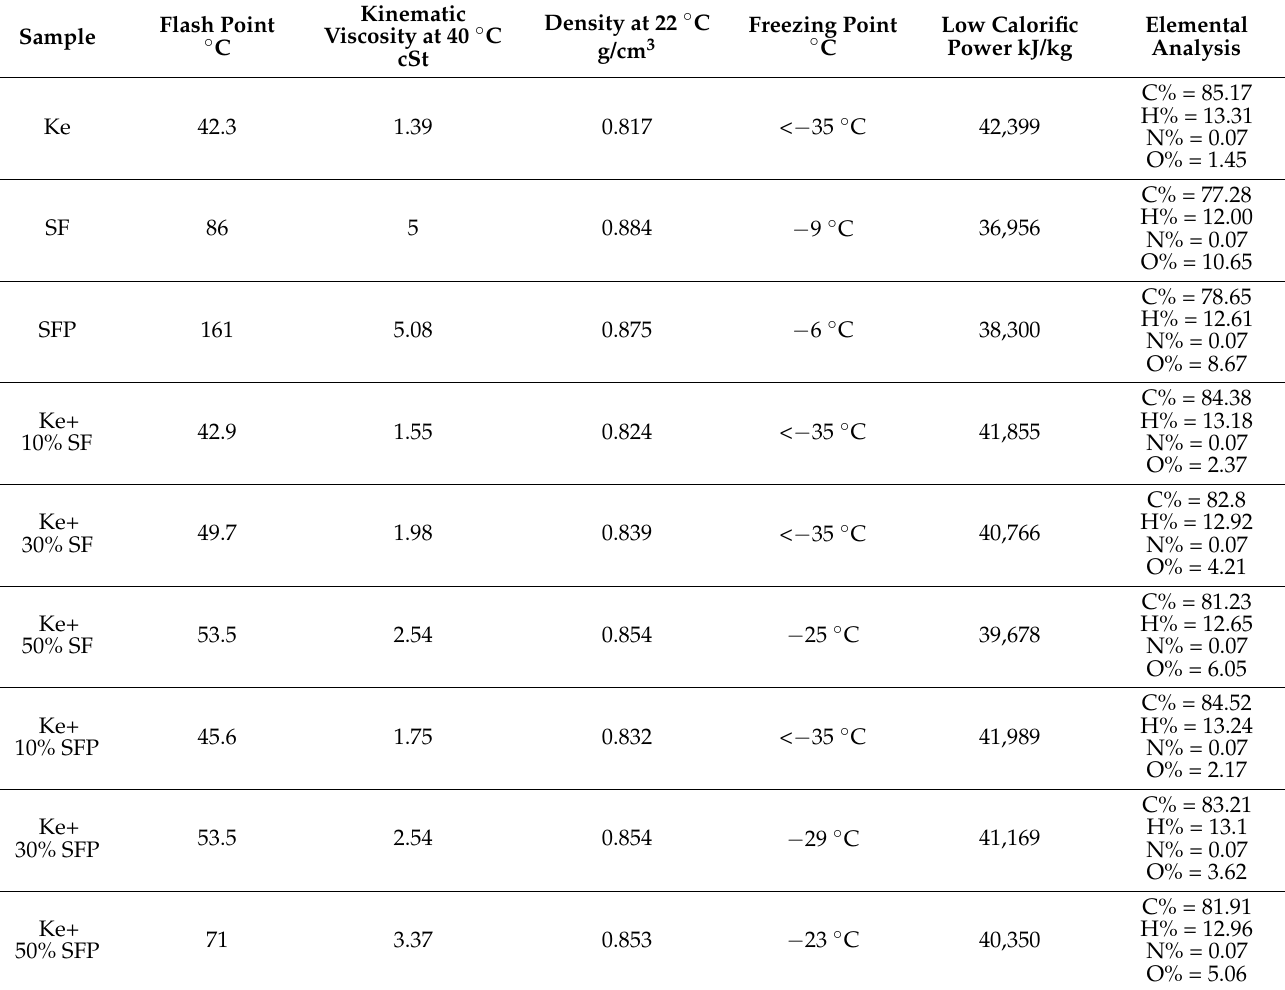
Table 1. Experimental results of the physical–chemical properties for fuel blends.